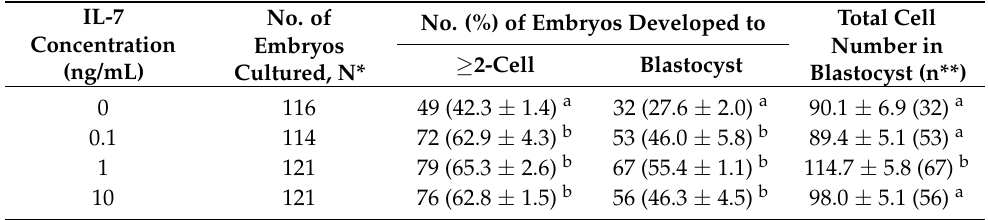
Table 3. Effect of interleukin-7 (IL-7) supplementation during in vitro maturation on developmental potential after par- thenogenetic activation.